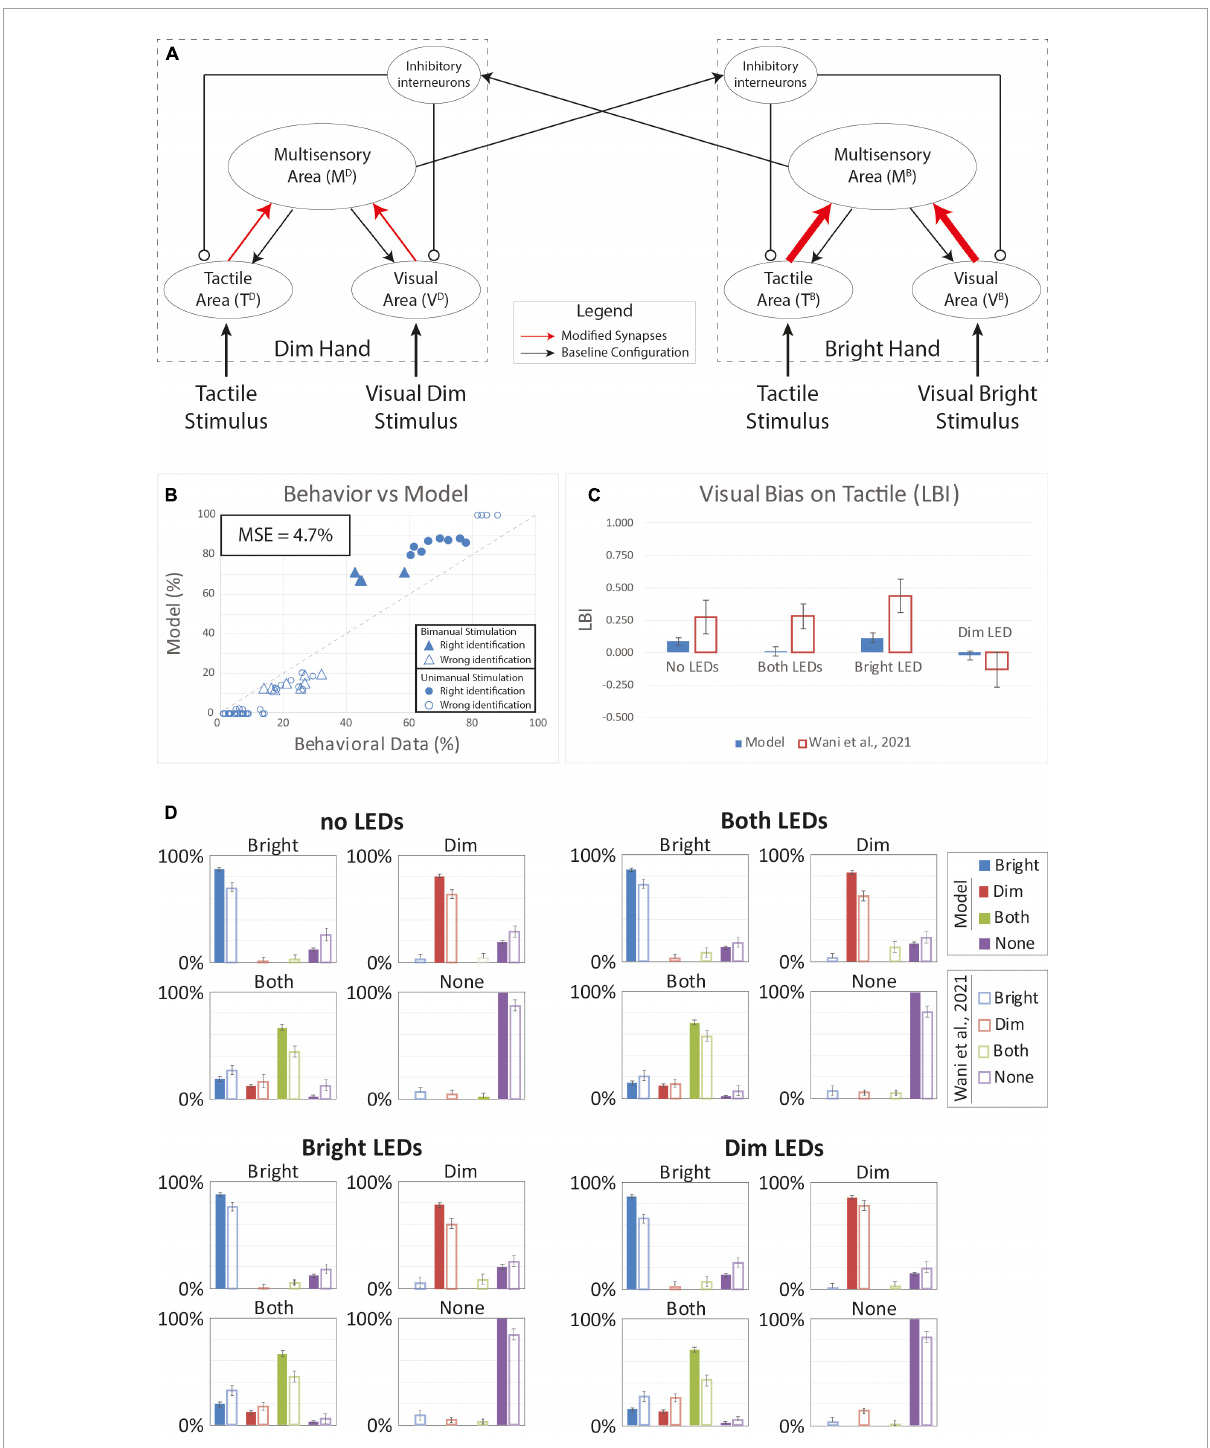
FIGURE4 Simulated results of the tactile perception with increased effectiveness of feedforward excitatory synapses. (A) Model’s structure with the altered pattern of connectivity. Red arrows highlighted the modified synapses. Thick synapses represent stronger reinforcement; thin arrows correspond to a weaker reinforcement. (B) Behavioral data from Wani et al. (2021) are compared with Model’s results, for the 16 different stimuli configurations. The dashed line represents the “perfect” match between simulations and behavioral results. In the diagram, the triangles represent the tactile responses in case of bimanual tactile stimulations, irrespective of the position of the visual stimuli. Full triangles refer to the percent correct identification of the bimanual tactile stimulation; empty triangles report the other responses (T on the bright or on the